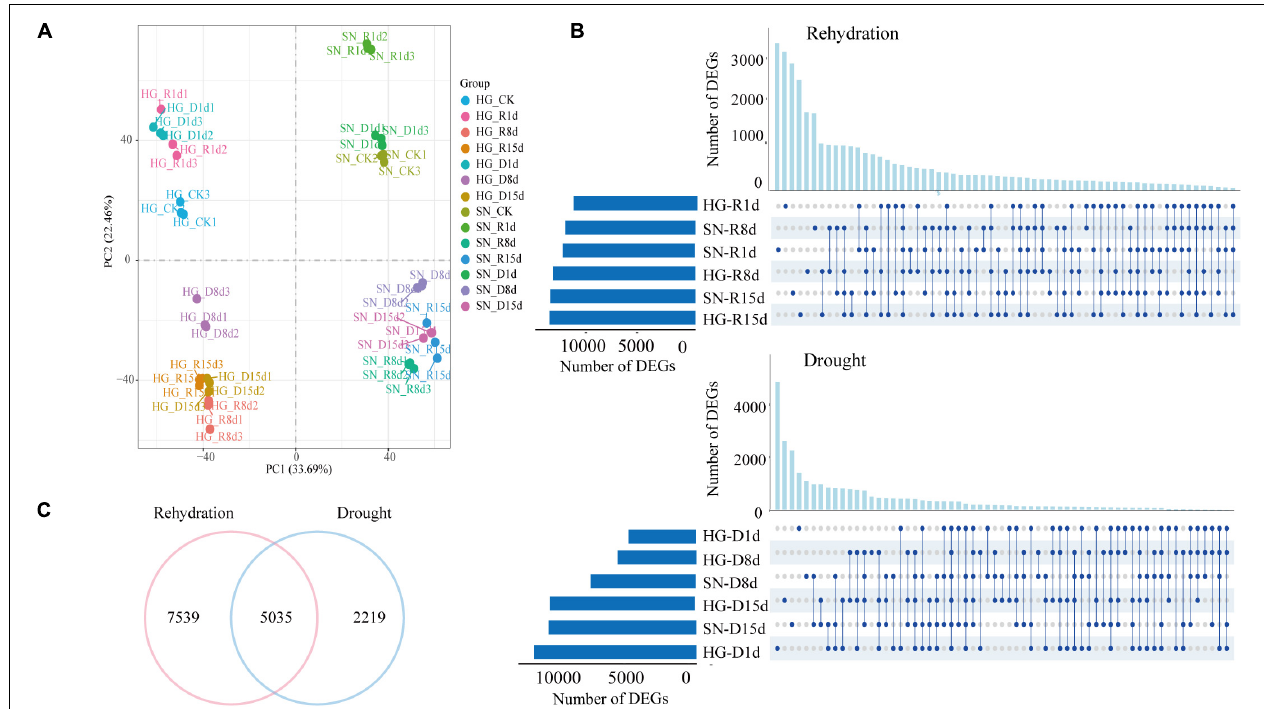
FIGURE 5 | Transcriptome responses of winter wheat upon rehydration and continuous drought stress. (A) A principal component analysis for the overall gene expression levels in all the sequenced RNA libraries was conducted to evaluate the correlations among different samples. (B) Upset diagrams showing the DEGs at 1, 8, and 15 dpr. The lines between the two points represent the specific expressed genes between the samples, and the length of the columns represent the number of genes. (C) Venn diagram showing numbers of rehydration-drought shared, rehydration-specific, and drought-specific DEGs.